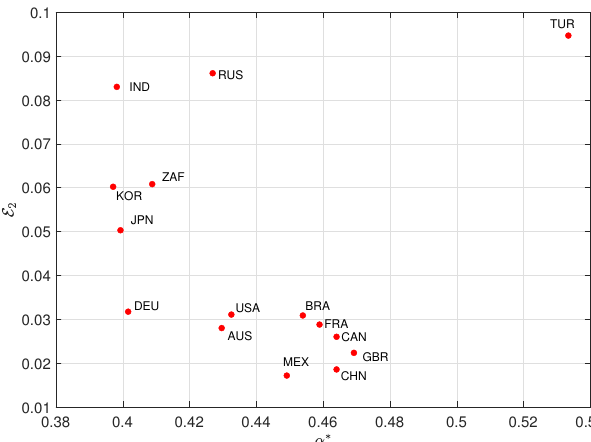
Figure 9. The locus of E 2 versus α ∗ for the set of 15 countries.